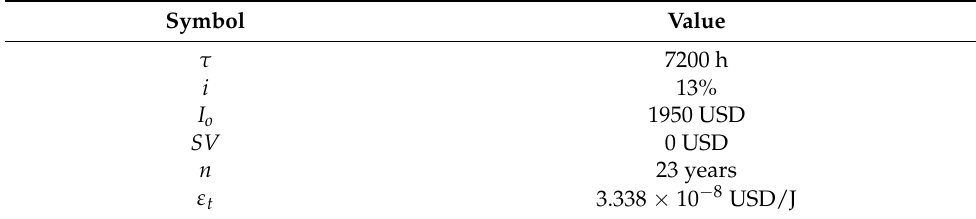
Table 3. The thermo-economic analysis list of